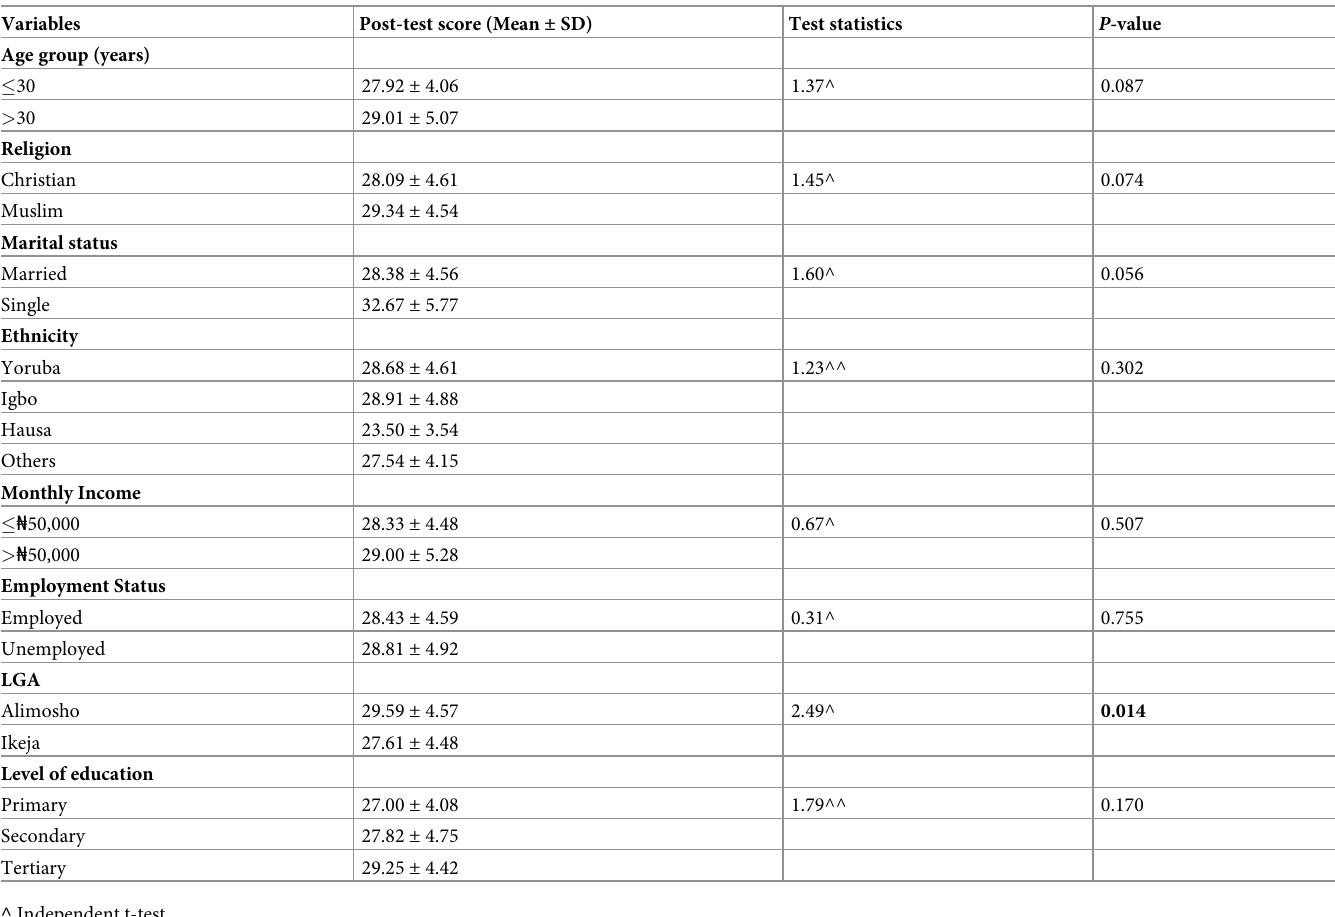
Table 10. Association between the socio-demographic characteristics of clients and preventive practice scores after interaction with trained PHC